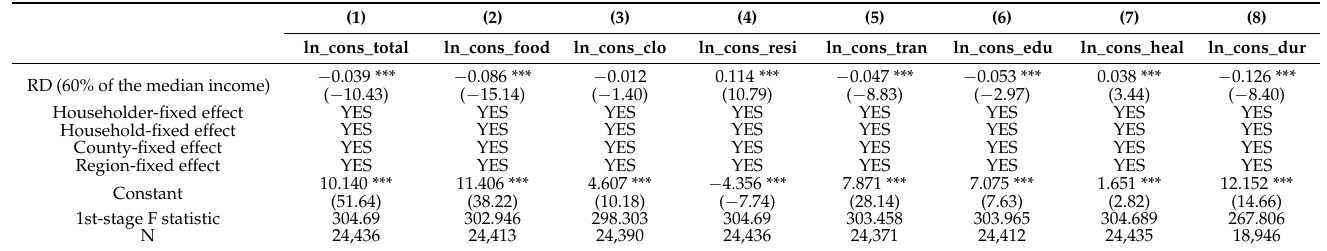
Table 5. Results of the robustness test (60% of the median income): IV